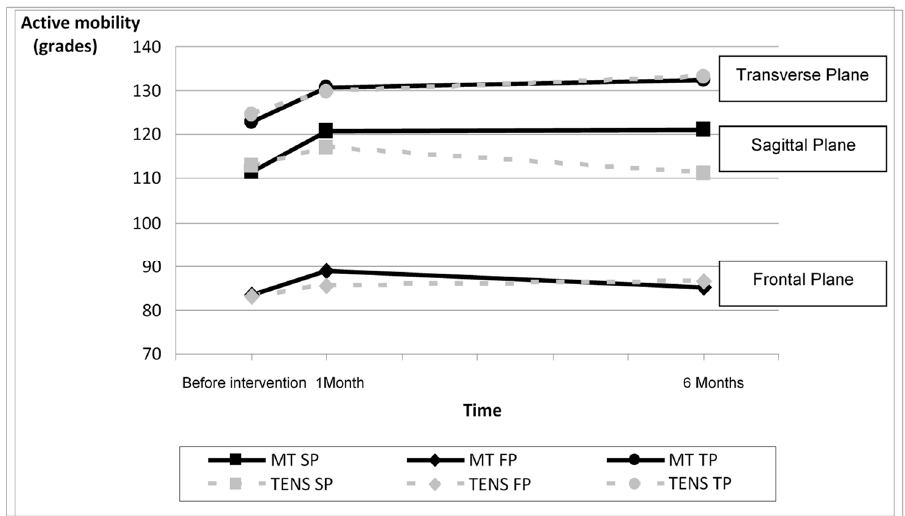
Figure 3. Active mobility evolution by planes in both intervention groups. Abbreviations: SP, sagittal plane; FP, frontal plane; TP, transverse plane; MT, manual Therapy; TENS, transcutaneous electric nerve stimulation.